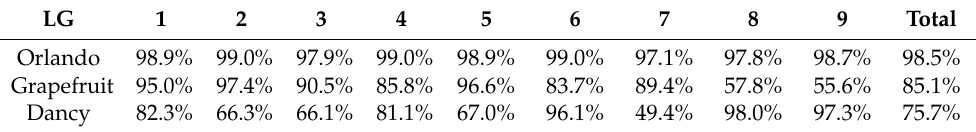
Table 5. Compatibility of the FH2 haplotype with three potential parents of ‘Fortune’.